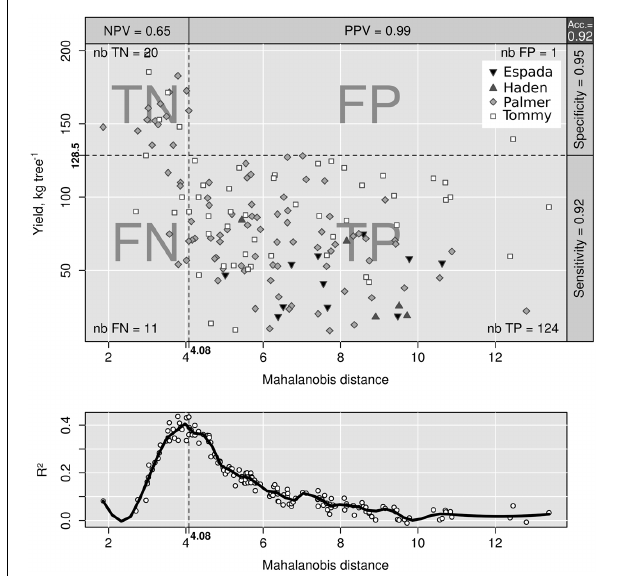
FIGURE 3 | Binary classification of data with indexes (top). Class sum of squares (bottom).